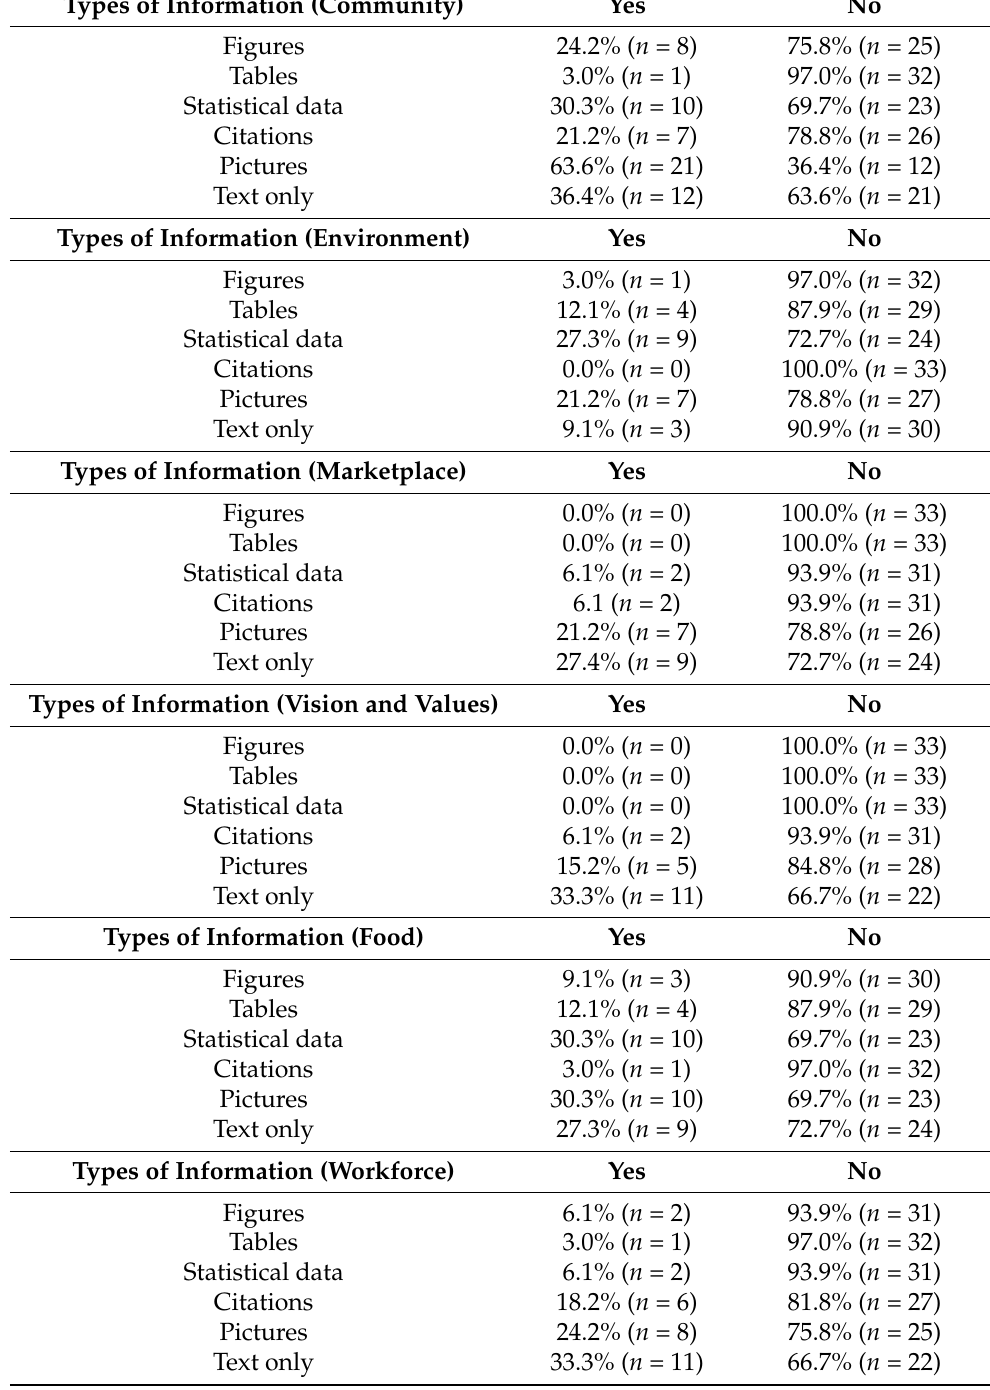
Table 11. Types of